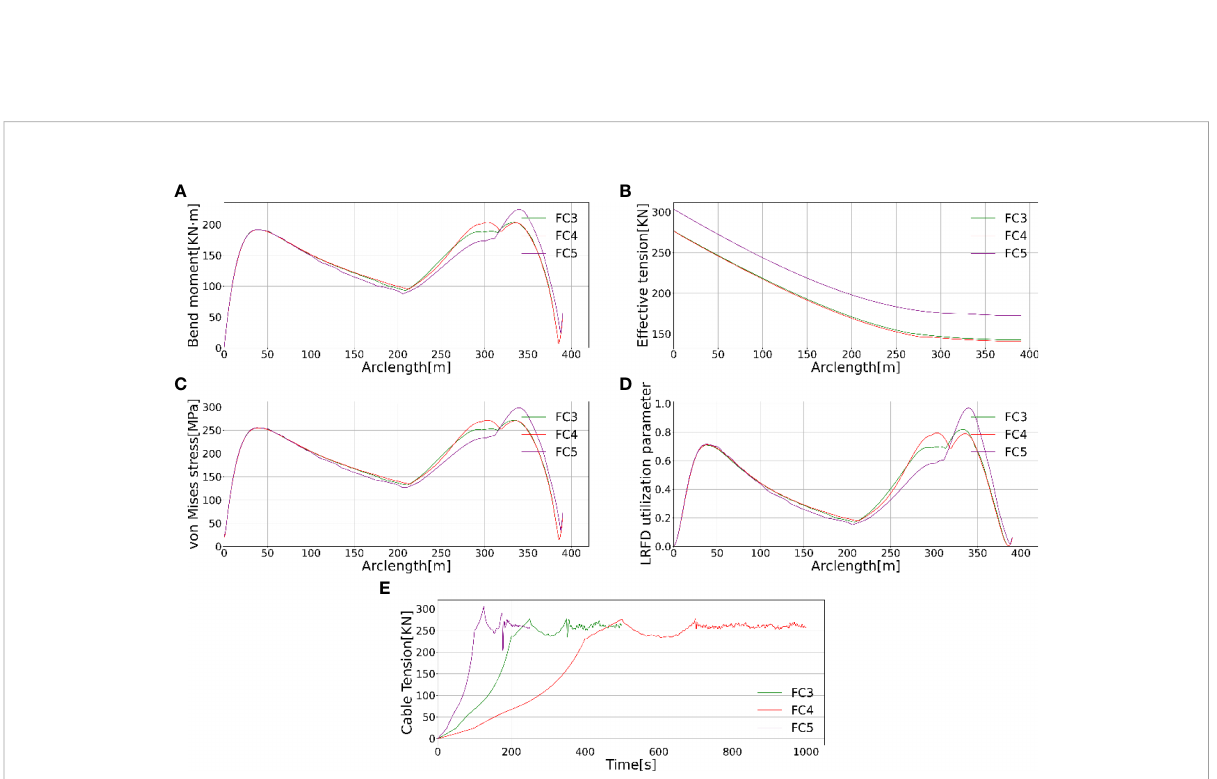
FIGURE 8 The bending moment (A) , effective tension (B) , Von Mises stress (C) , LRFD utilization (D) and cable tension (E) time history for velocity coordination sensitivity